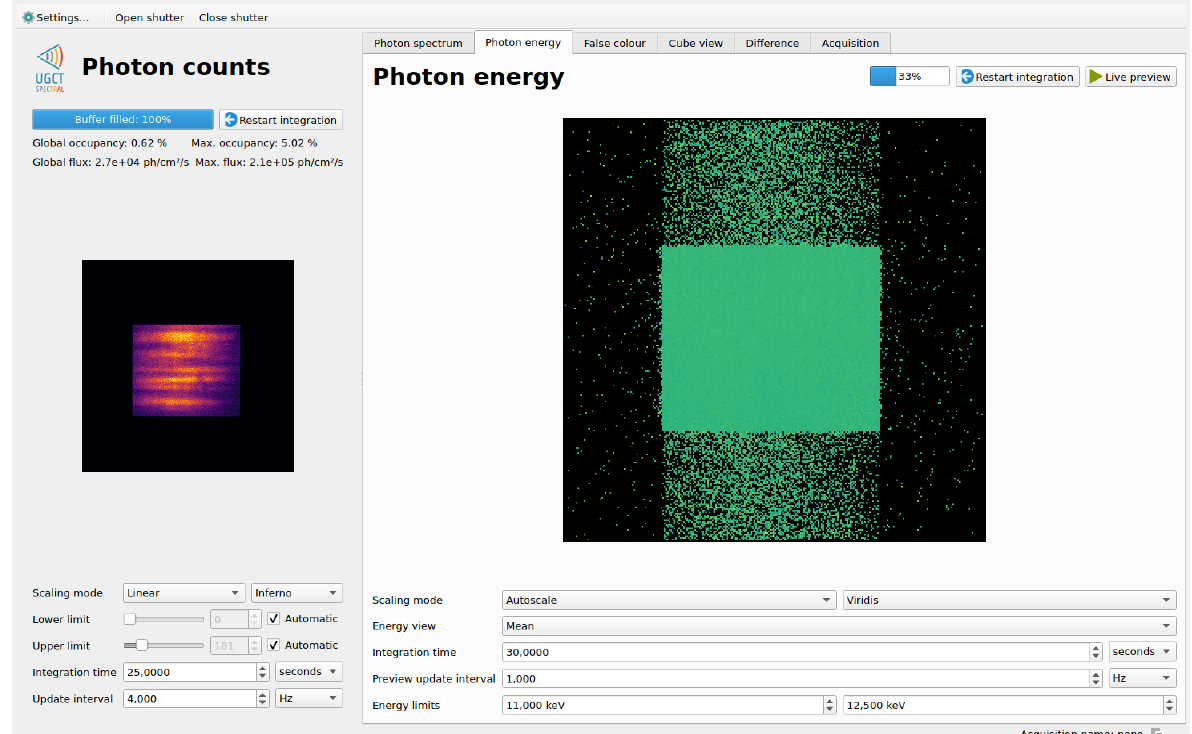
Figure 8. The main SpeXIDAQ GUI as used during a recent beamline diagnostics measurement. The integrated counts view on the left shows clear intensity variations caused by the monochromator, while the mean energy shows no fluctuations in the spectrum. The vertical distribution of signals above and below the main aperture is an artefact of the CCD readout. The flux in the illuminated region of the sensor was 2.1 × 10 5 phs − 1 cm − 2 for a pixel occupancy of